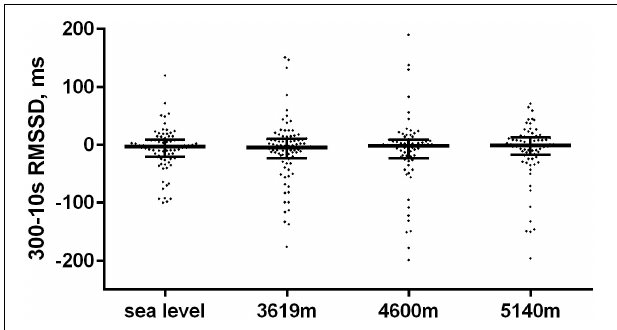
FIGURE 2 | The differences in paired RMSSD (300 s – 10 s) values with increasing